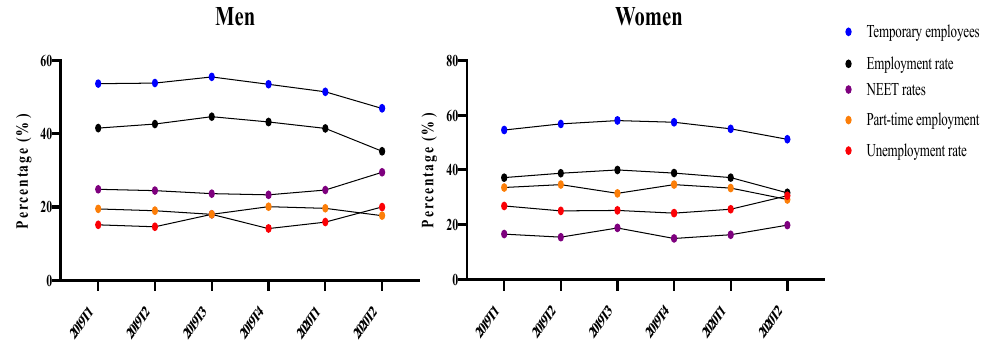
Figure 8. Evolution of the population according to the type of employment by gender, Spain 2019– second semester of 2020. Source: Our own elaboration through EPA microdata.